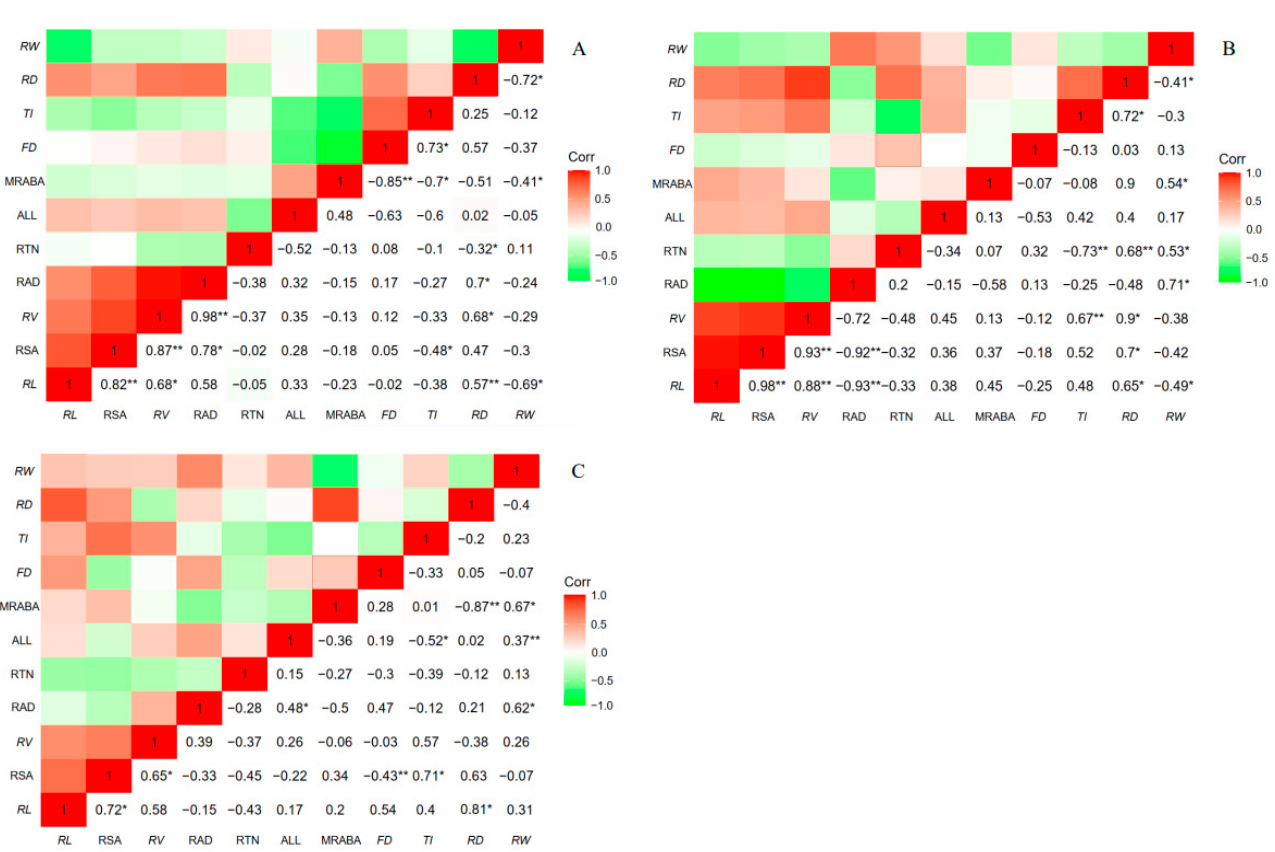
Figure 4. Correlation analysis between spatial distribution and geometric morphology among different propagation methods of seed germination ( A ), tissue culture ( B ), and rooted cutting ( C ). * means significant difference ( p < 0. 05); ** means extreme significant difference ( p < 0.01). RL = root length; RSA = root surface; RV = root volume; RAD = root average diameter; RTN = root tip number; ALL = average link length; MRABA = main root average branch angle; FD = fractal dimension; TI = topological index; RD = root depth; RW = root width.